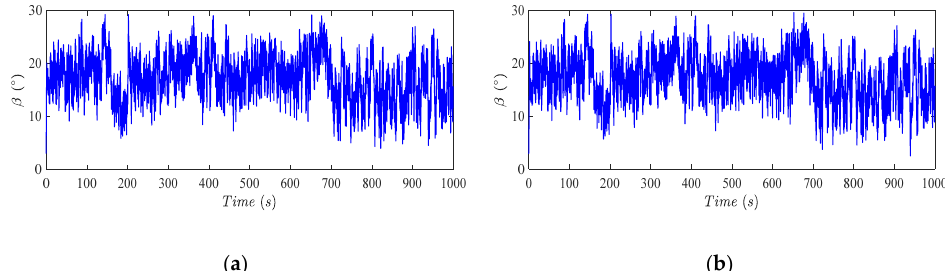
Figure 9. Reference pitch angle under single ( a ) and simultaneous faults ( b ).